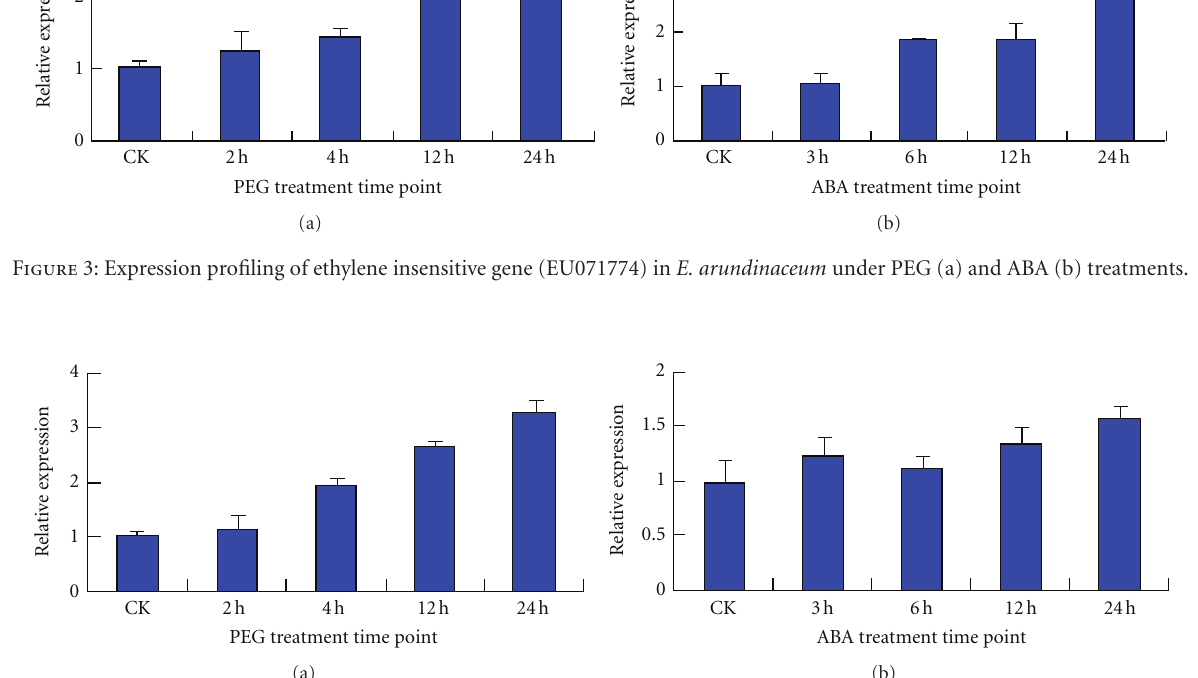
PEG treatment time